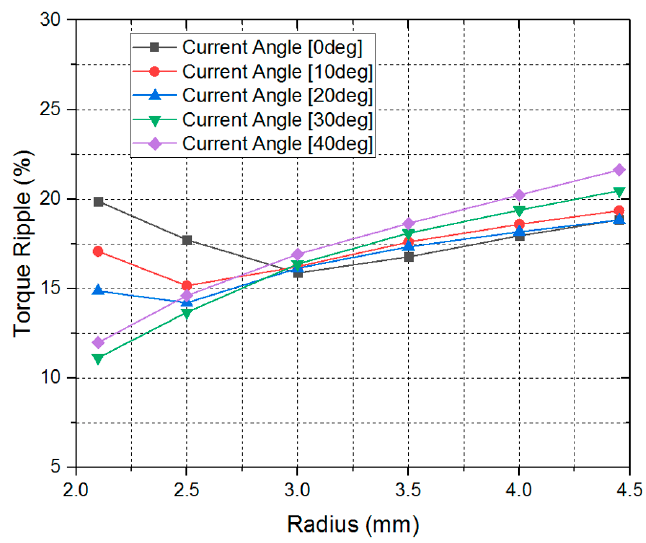
Figure 9. Comparative analysis of cogging torque when notch shape distance (1) is 0.5 mm.